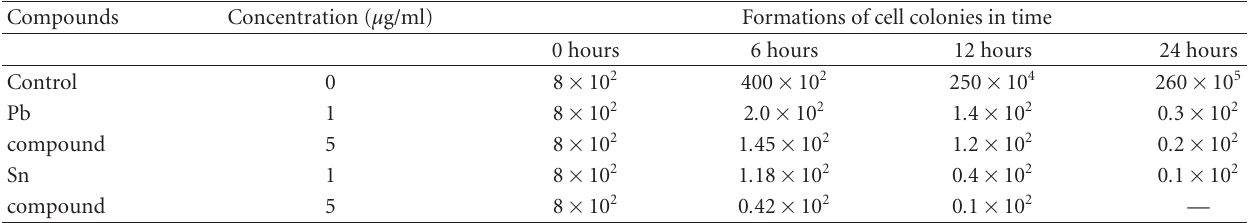
Table 2: Dependence of survival of Saccharomyces cerevisiae D273-10B/A 1 doped with Triphenyltin chloride and Triphenyllead chloride on